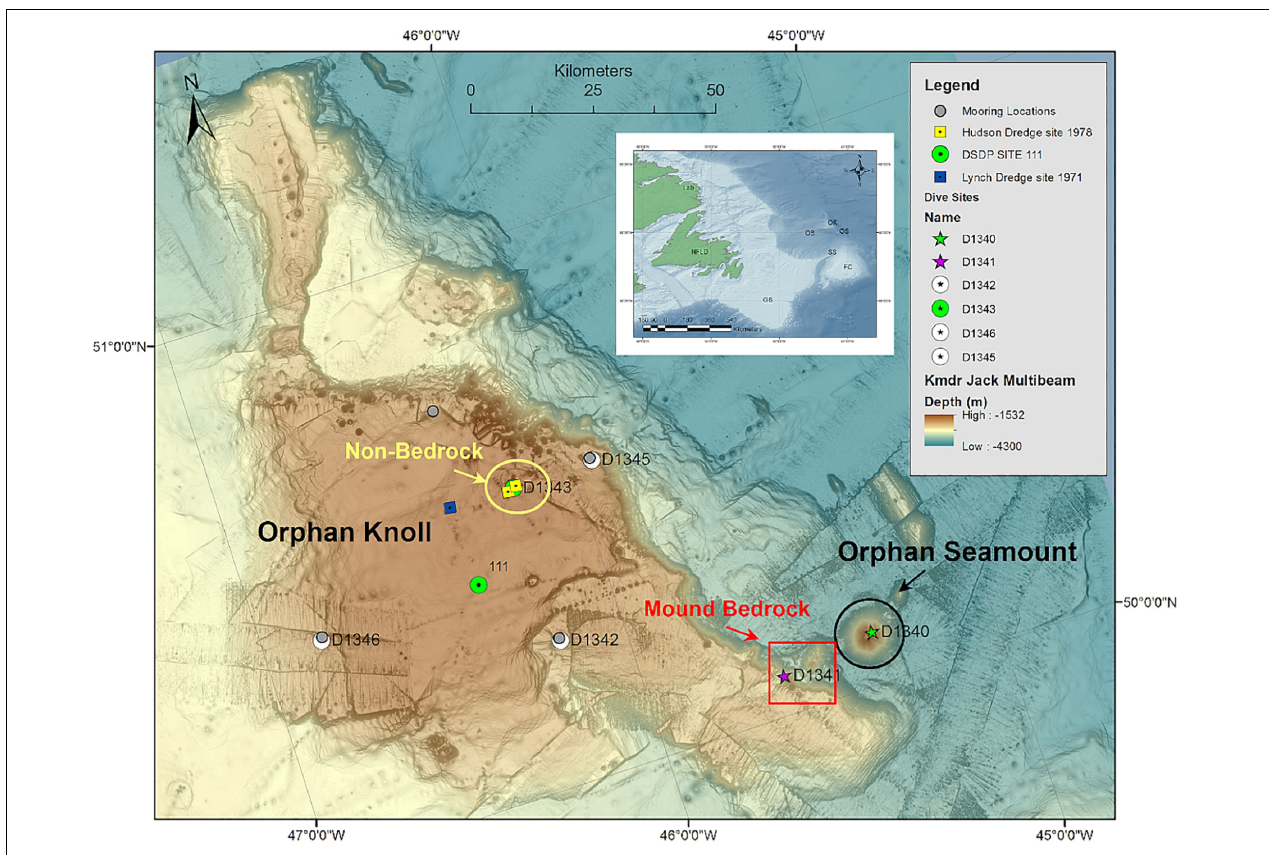
FIGURE 1 | Location of Orphan Knoll and of features studied in detail. Inset map: NFLD, Island of Newfoundland; Lab, Labrador; GB, Grand Banks of Newfoundland; OK, Orphan Knoll; OS, Orphan Seamount; OB, Orphan Basin; FC, Flemish Cap; SS, Sackville Spur. Main figure: Bathymetry is a mosaic of archival multibeam sonar from USCGC Healy and MV Kommandor Jack data (see Supplementary Material ) with GEBCO bathymetry for region. Positions of previous drilling (DSDP site 111) and rock dredge sampling ( USNS Lynch , 1971, CCGS Hudson , 1978) also shown, as well as locations or remotely operated vehicle (ROV) dives completed during CCGS Hudson 2010-029 mission. TABLE 1 | ROPOS dives during the Hudson 2010-029 mission.